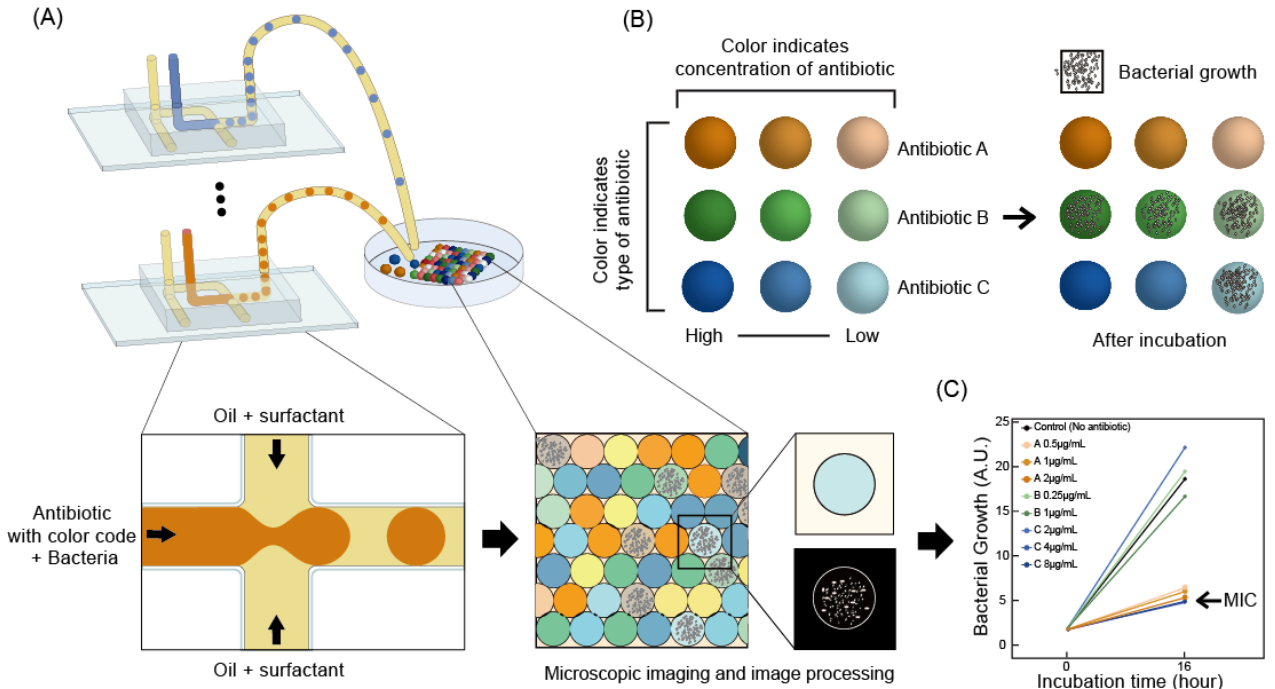
Figure 2. A schematic illustration depicting the creation and analysis of color-coded droplets for antibiotic susceptibility testing. ( A ) Overall processing: generating color-coded droplets, incubating in a single culture well, a microscopic image of the droplet, decoding the color code, and measuring bacterial growth. ( B ) Strategy to generate color code for type and concentration of antibiotics. ( C ) Final determination of MIC values in each antibiotic.